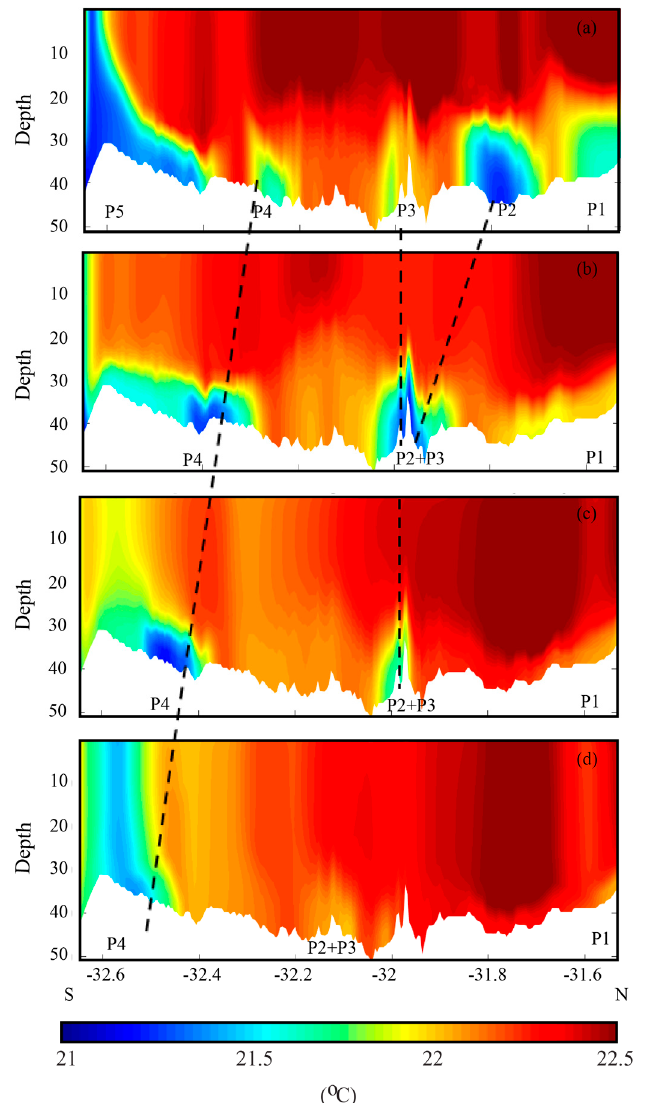
Figure 9. Predicted daily mean temperature along a shore-parallel transect (view from land with south located to the left) along the 40 m depth contour: ( a ) May 13, 2016; ( b ) May 14, 2016; ( c ) May 15, 2016; and ( d ) May 16, 2016. P1–P5 are related to the flow pathways defined in Figure 8.